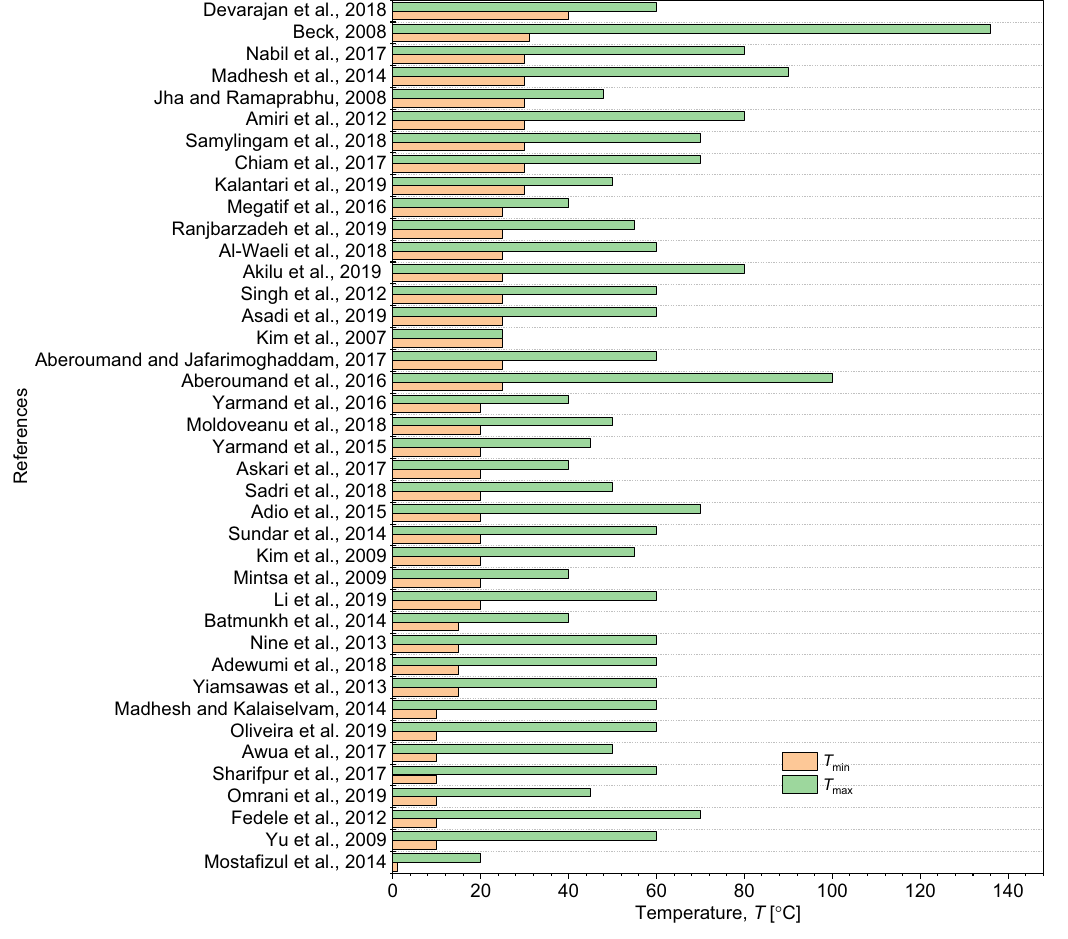
Figure 12: Range of